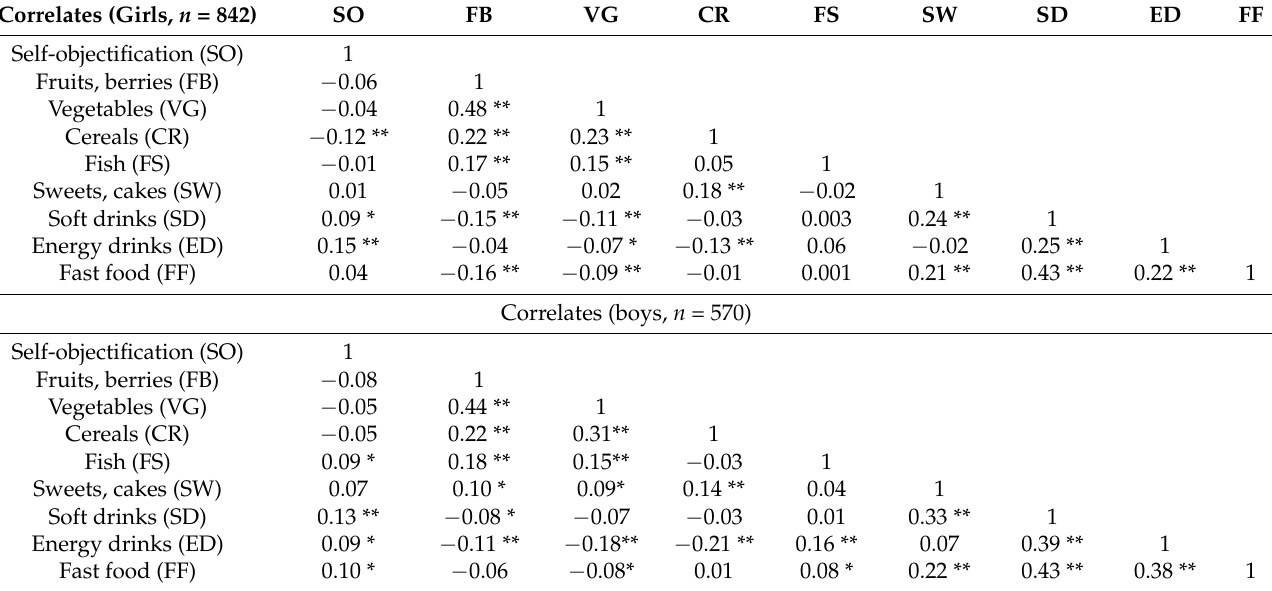
Table 4. Associations between self-objectification and dietary habits in adolescent boys and girls ( n =